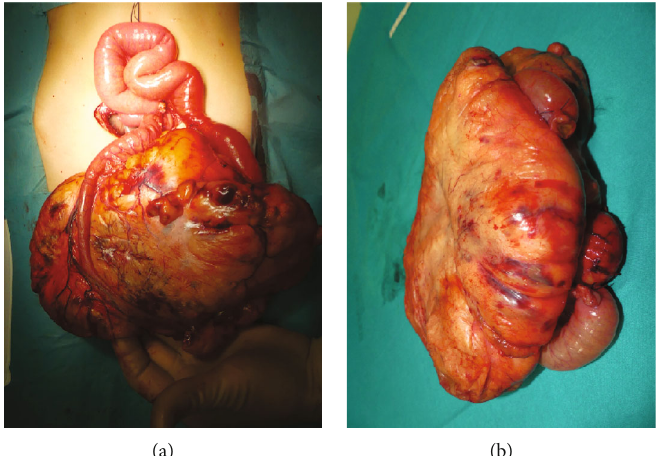
Figure 2: (a, b) Intraoperative fi ndings: the mass comes from the mesentery, stretching the involved ileum (a), which was resected together with the mass (b).